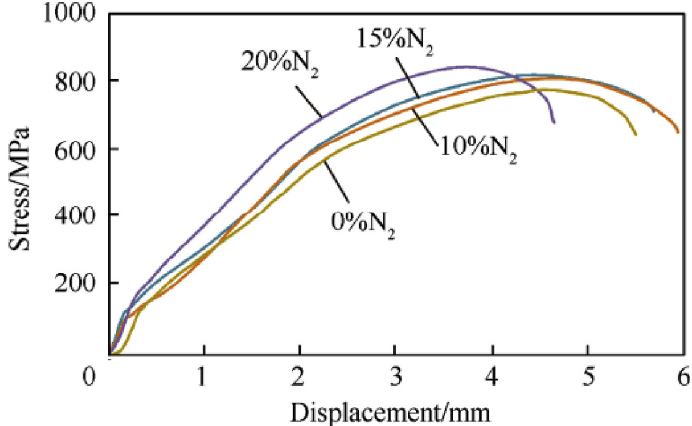
Figure 10. Tensile curves of the HNS welded structure with different nitrogen contents in the shielding gas. Reprinted with permission from ref. [37]. Copyright 2021, Elsevier.